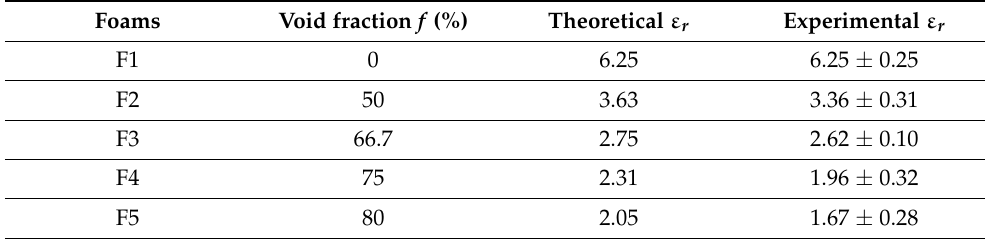
Table 3. Dielectric constant of silicone rubber foams without graphene. Foams Void fraction f (%) Theoretical ε r Experimental ε